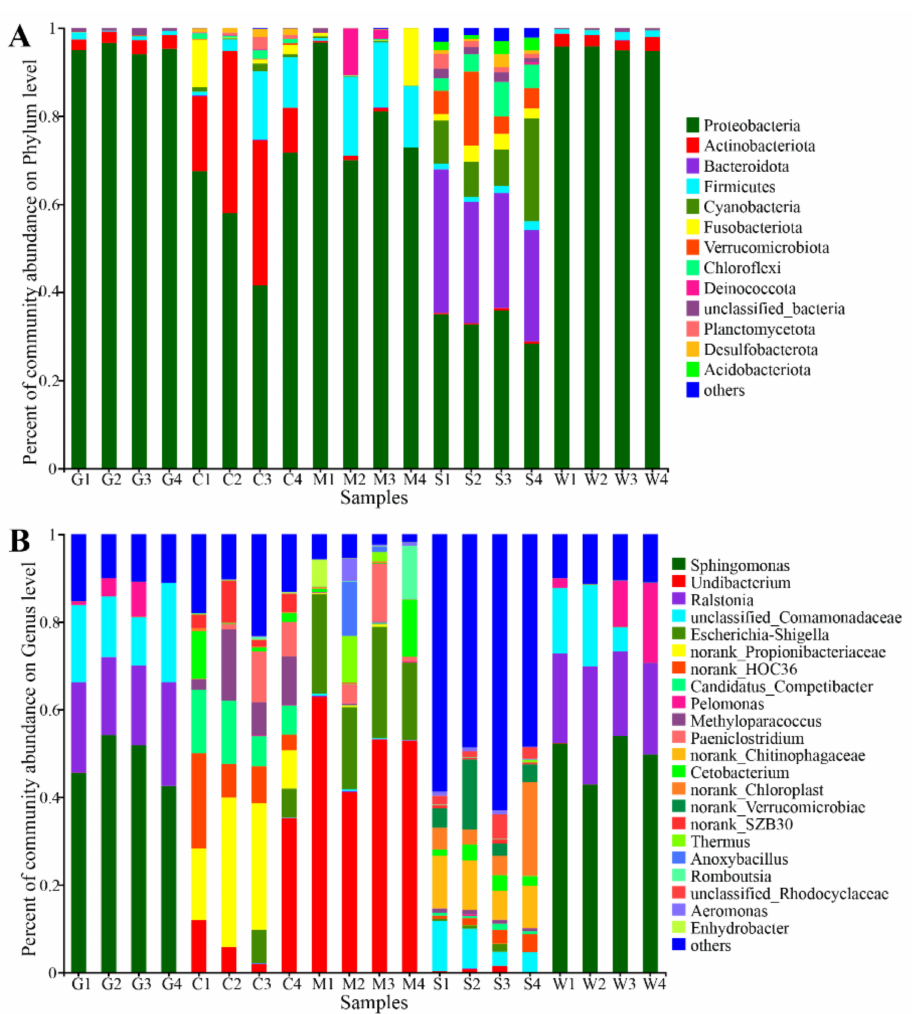
Figure 3. Distribution of the bacterial communities in all twenty samples at ( A ) the phylum level or ( B ) the genus level. G: gill mucosae (G1–G4); C: intestinal contents (C1–C4); M: intestinal mucosae (M1–M4); S: stomach contents (S1–S4); W: stomach mucosae